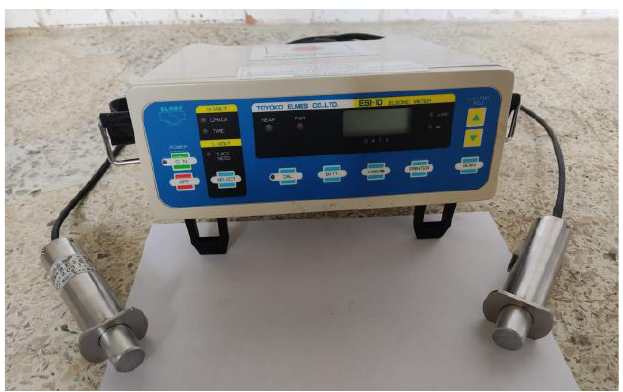
Figure 10. Ultrasound